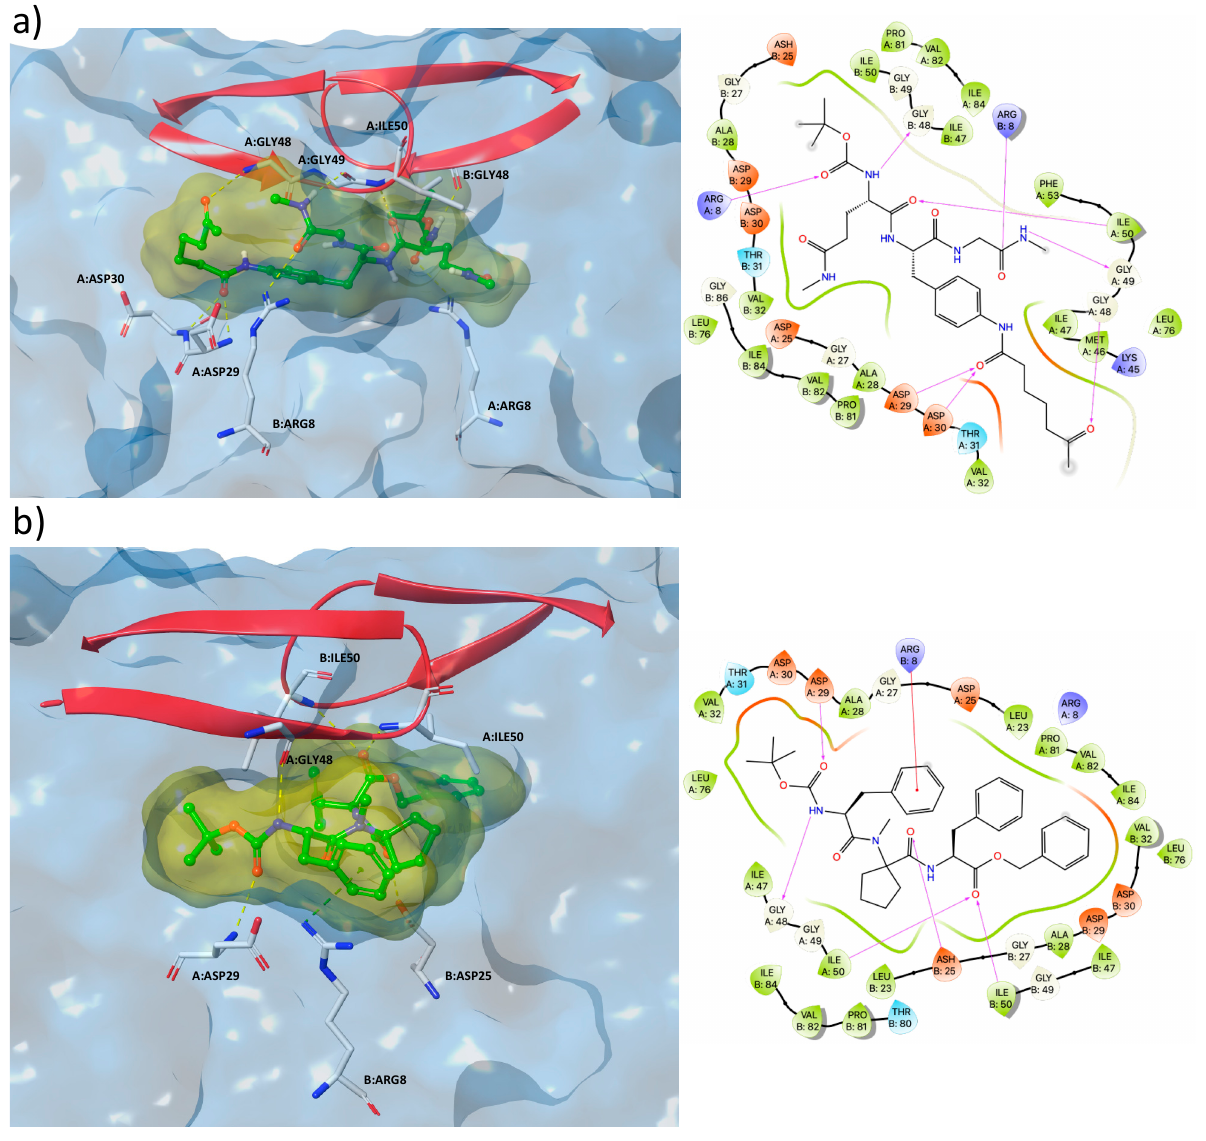
Figure 5. 3D binding modes (left) and amino acids maps (right) of the best docked pose of NSC669704 ( a ) and NSC672457 ( b ), bound to the catalytic domain of HIV-1 PR (PDB id: 1HVR).